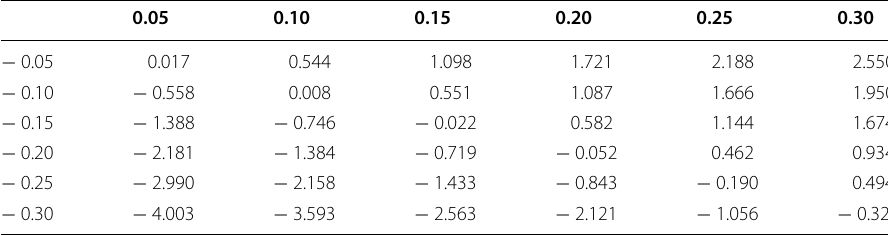
The first row shows the φ values, whereas the first column shows the φ + been multiplied by 10 5 for better presentation